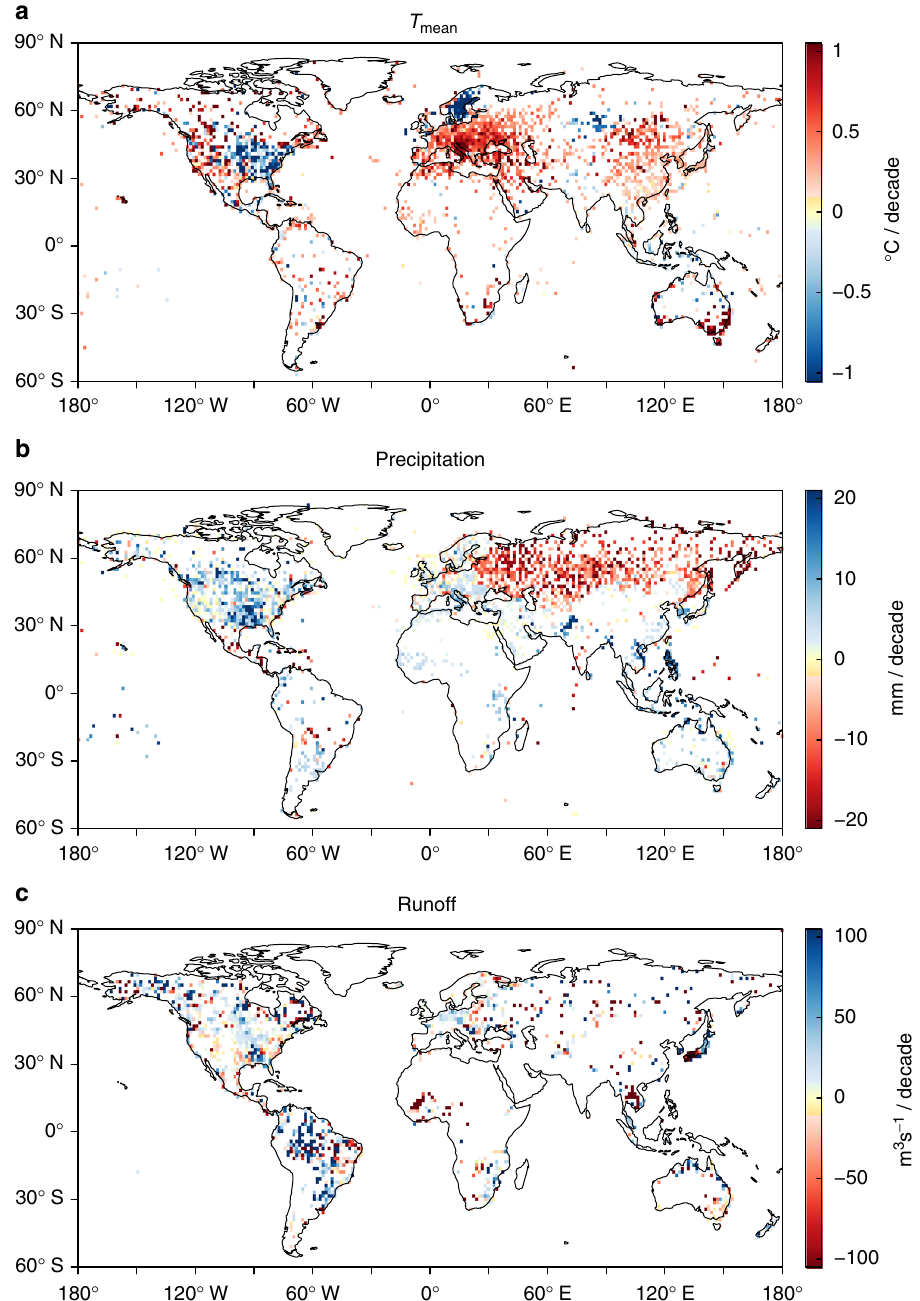
Fig. 1 Global trend results for annual 99th percentile daily extremes during 1929 – 2017. a – c Trend of T mean ( a ), precipitation ( b ) and runoff ( c ), respectively. White indicates grids with insuf fi cient data or that the trend is insigni fi cant at a 0.05